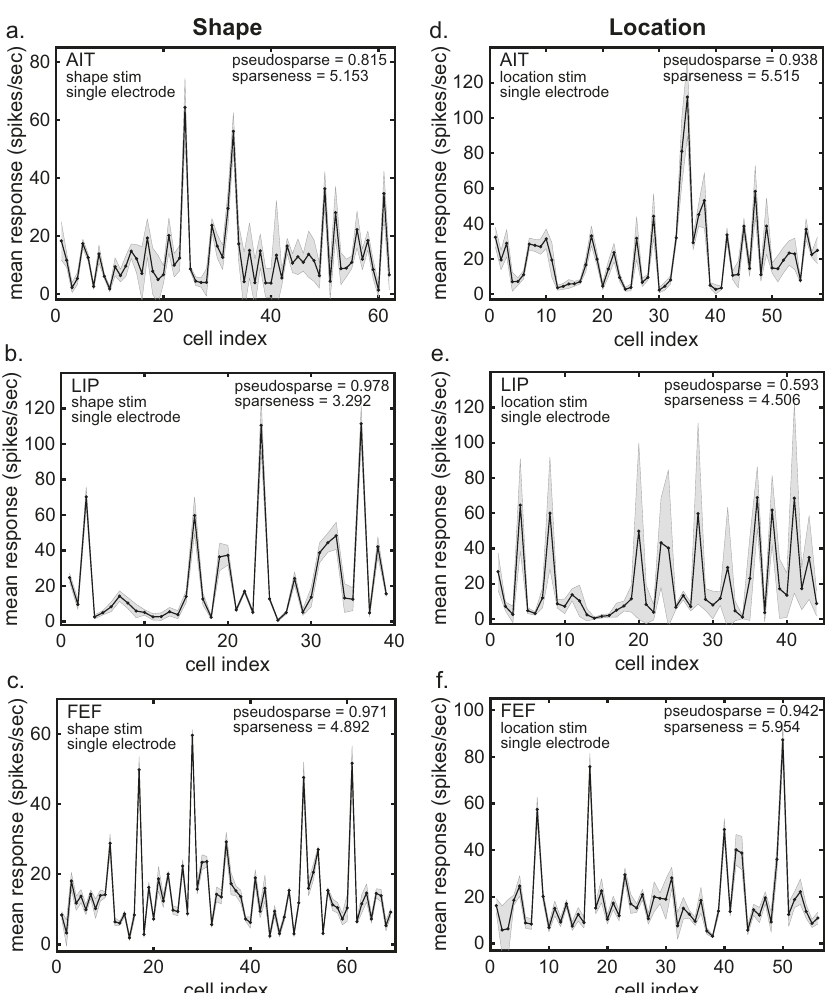
Fig. 6 Response spectra for three cortical areas using either shape or retinotopic location stimuli. a Anterior inferotemporal cortex (AIT) data for stimulus shape. N = 85 neurons with n = 8 stimuli per neuron (Data from Lehky and Sereno 12 ). b Lateral intraparietal cortex (LIP) data for stimulus shape. N = 53 neurons with n = 8 stimuli per neuron (Data from Lehky and Sereno 12 ). c Frontal eye fi eld (FEF) data for stimulus shape. N = 72 neurons with n = 8 stimuli per neuron (Data from Peng et al. 39 ). d AIT data for stimulus location. N = 83 neurons with n = 8 stimuli per neuron (Data from Lehky et al. 40 and Sereno and Lehky 11 ). e LIP data for stimulus location. N = 65 neurons with n = 8 stimuli per neuron (Data from Lehky et al. 40 and Sereno and Lehky 11 ). f FEF data for stimulus location N = 62 neurons with n = 8 stimuli per neuron (Previously unpublished data). Gray error bars represent standard